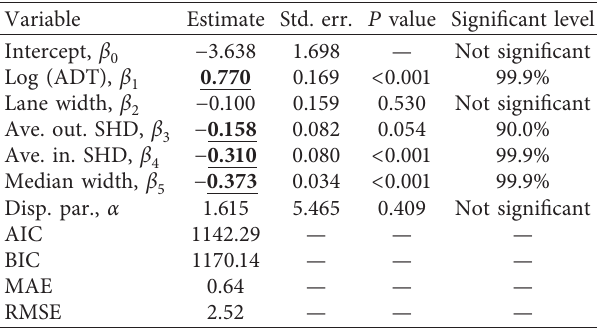
Table 2: Estimating results of the ZTNB